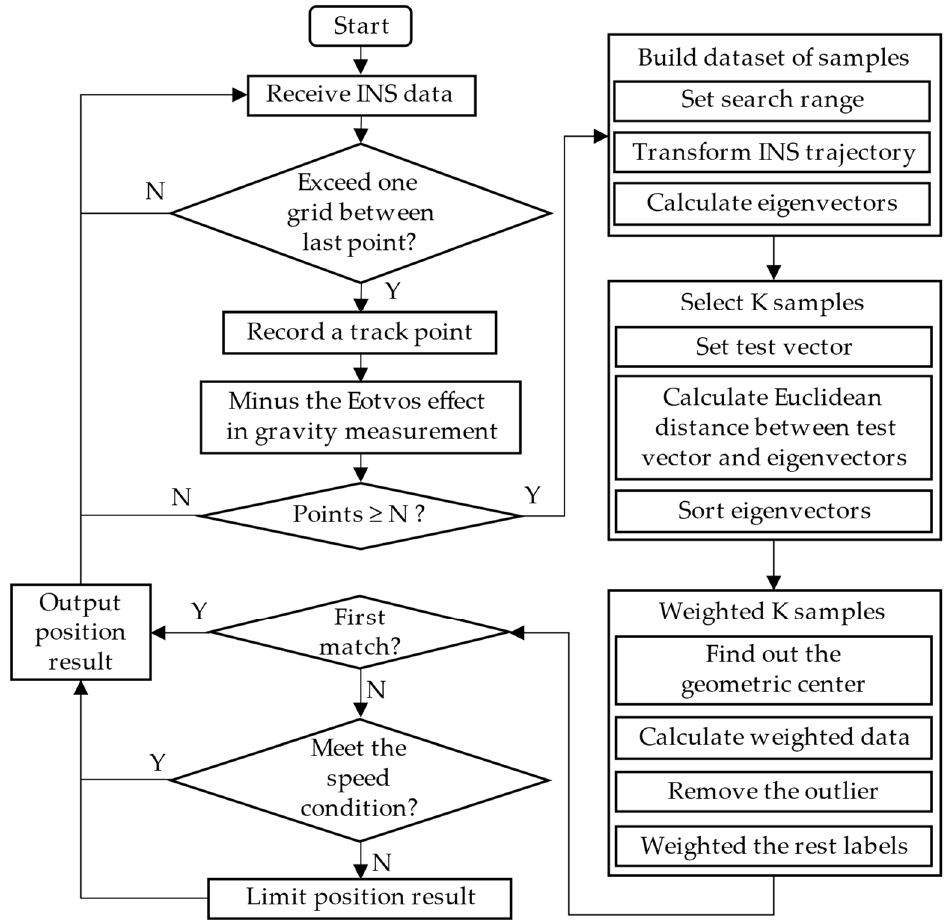
Figure 3. Flowchart of gravity-matching algorithm based on KNN.